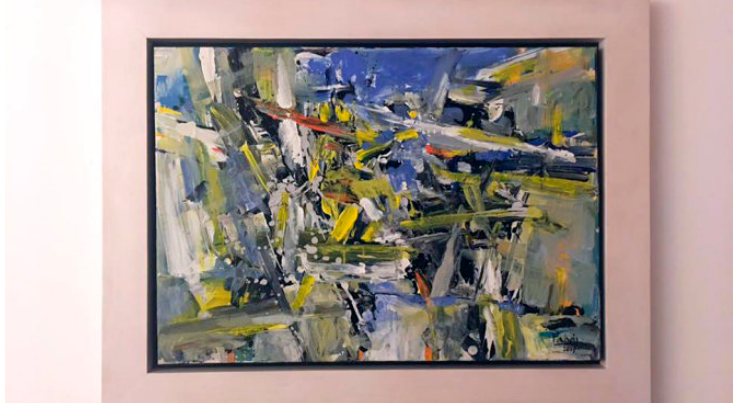
Figure A2. Nguyen Ro Hung original painting 1. The image was sourced from Tuoi Tre Newspaper (Viet 2017).